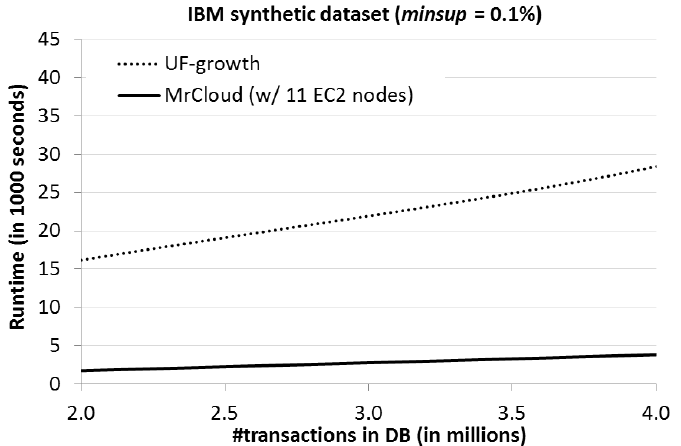
Figure 1. Runtime vs. #transactions.